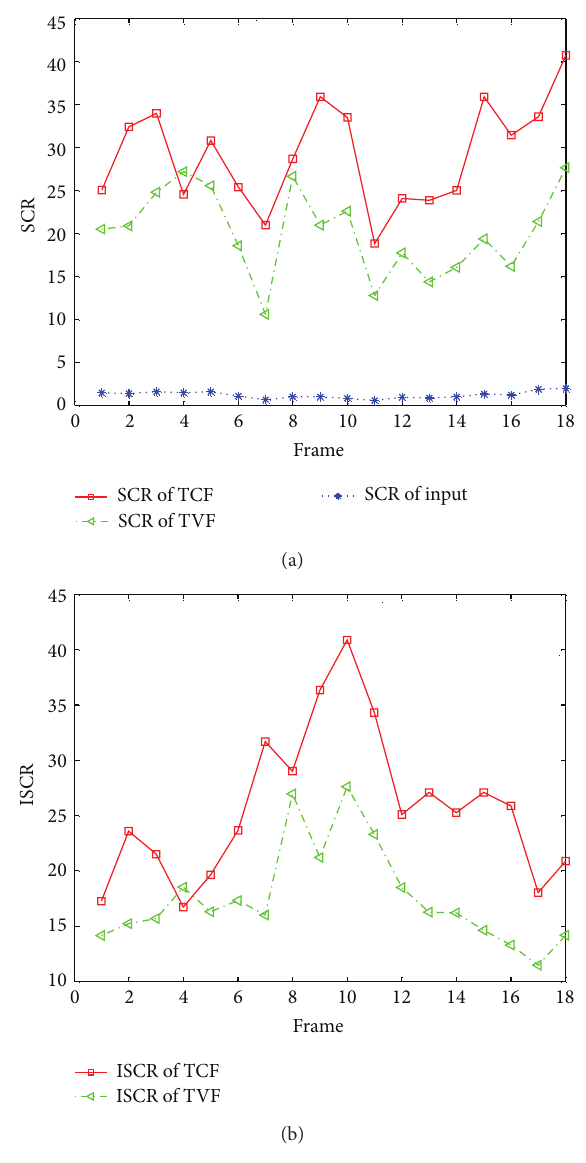
Figure 18: Comparative analysis of temporal filters for test sequence (Set 4): (a) SCR values for input, TCF, and TVF; (b) ISCR values for TCF and